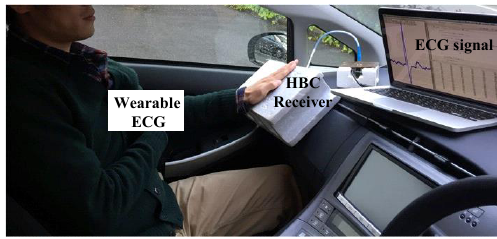
Figure 6: ECG signal processed by moving average (cid:28)lter when